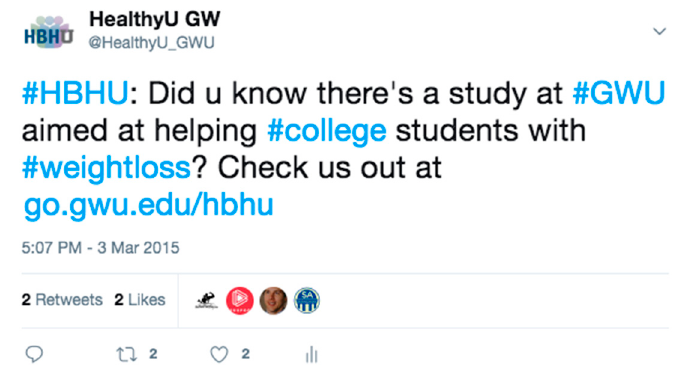
Figure 2. HBHU Facebook post 2.